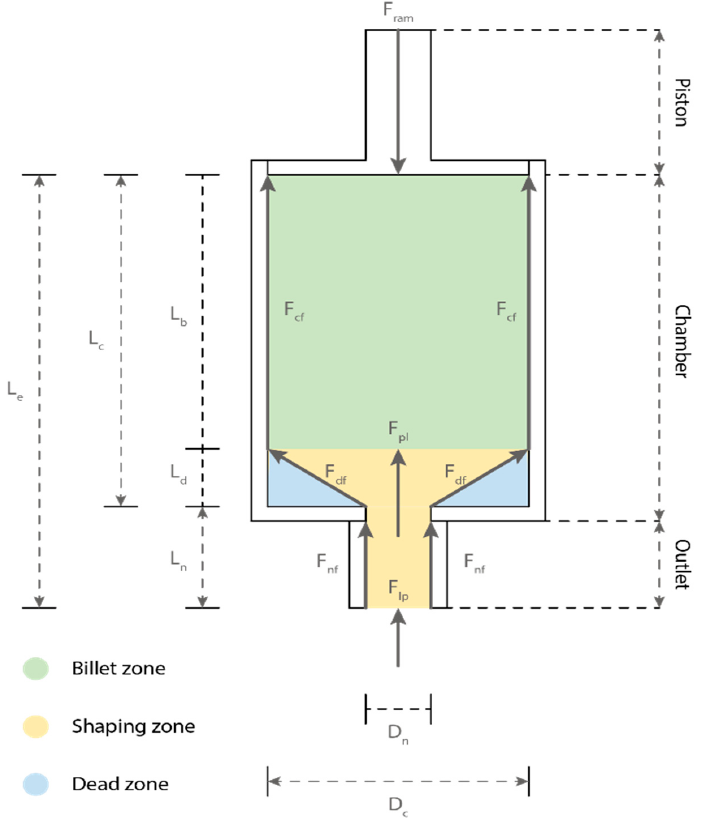
Figure 2. The printhead of a typical ram extrusion for E3DCP.